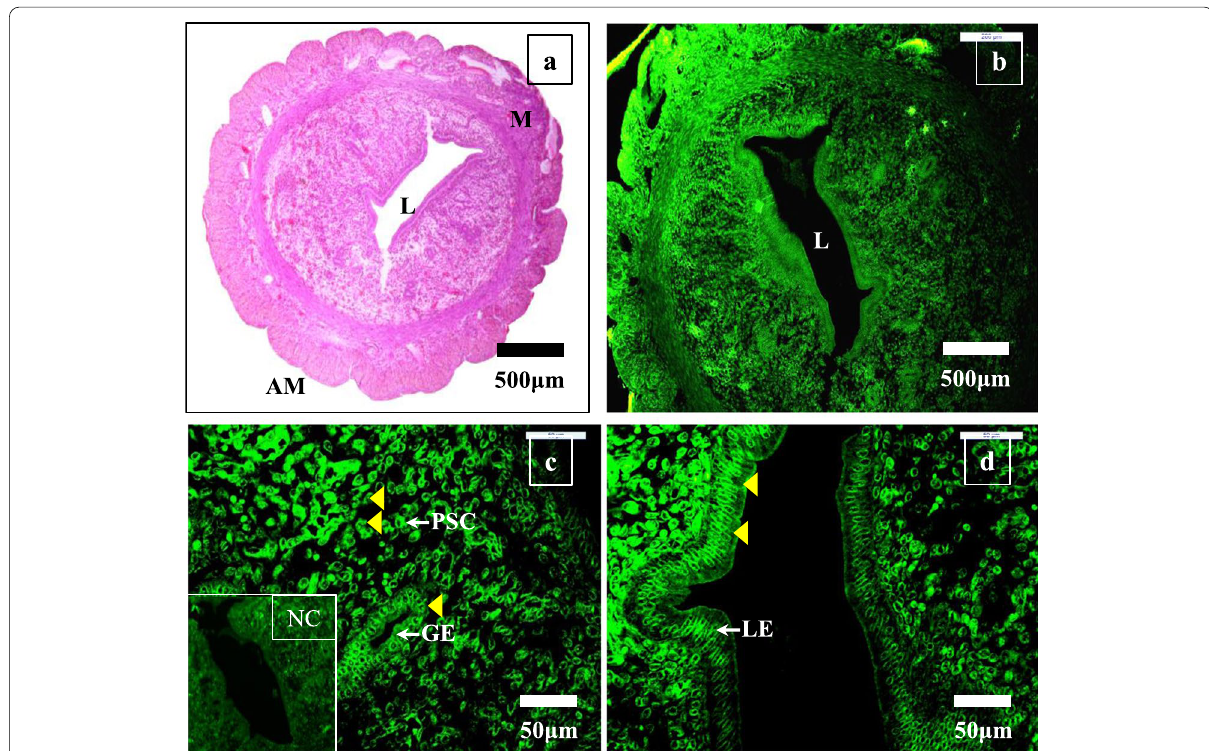
Fig. 2 Immunofluorescent localization of KLF5 on D4 mice uterus using FITC-conjugated antibody. The protein was localized in the luminal epithelium (LE) and glandular epithelium (GE) of uterine glands and the proliferating stromal cell (PSC). The arrowhead indicates the expression.